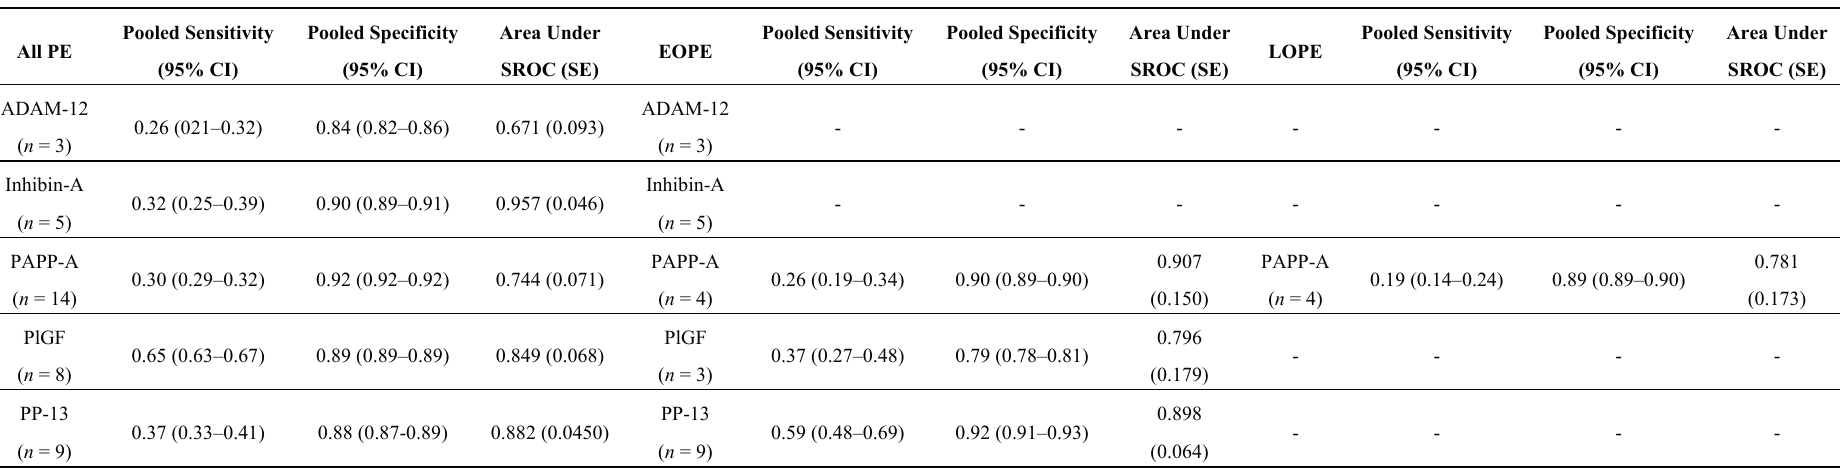
Table 2. Meta-analyses of single laboratory